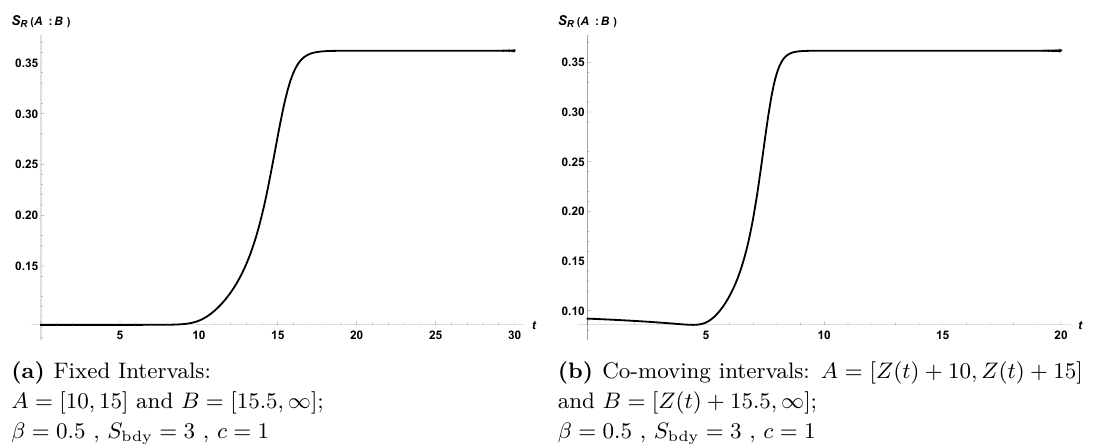
Figure 14. Page curves for the reflected entropy between two disjoint intervals in a escaping mirror BCFT 2 .